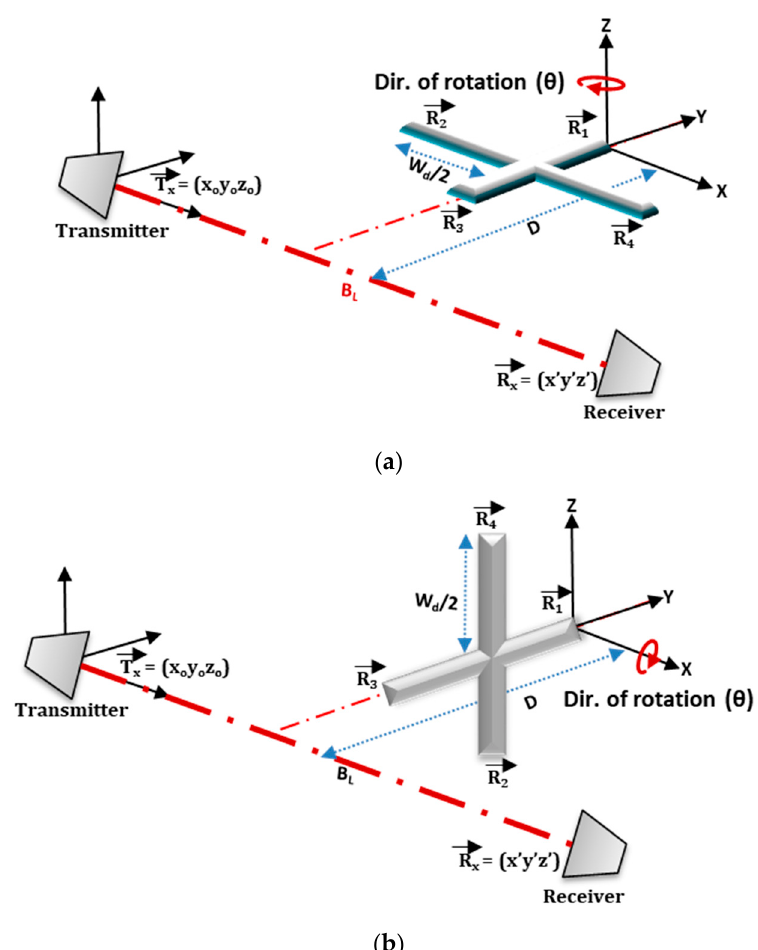
Figure 2. Drone blade model in FSR (Forward Scattering Radar) geometry for blade ( a ) Facing-Up and ( b ) Facing-Receiver.